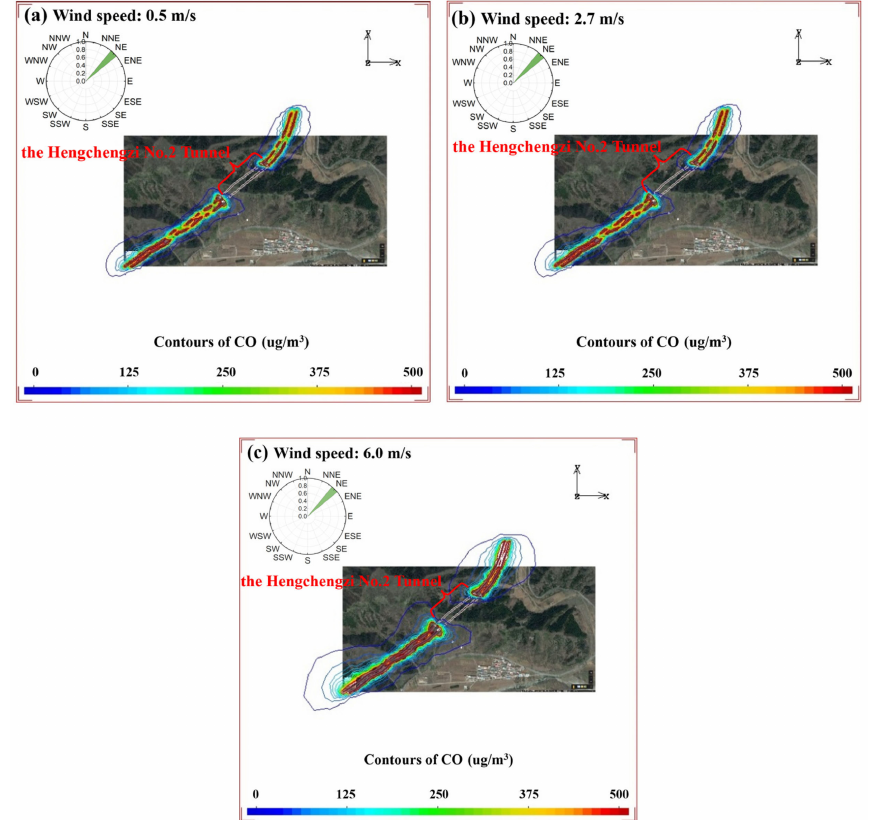
Figure 14. Concentration distribution of CO under different wind speeds in the Hengchengzi No. 2 Tunnel section. ( a ) Low wind speed (0.5 m/s); ( b ) Medium wind speed (2.7 m/s); ( c ) High wind speed (6.0